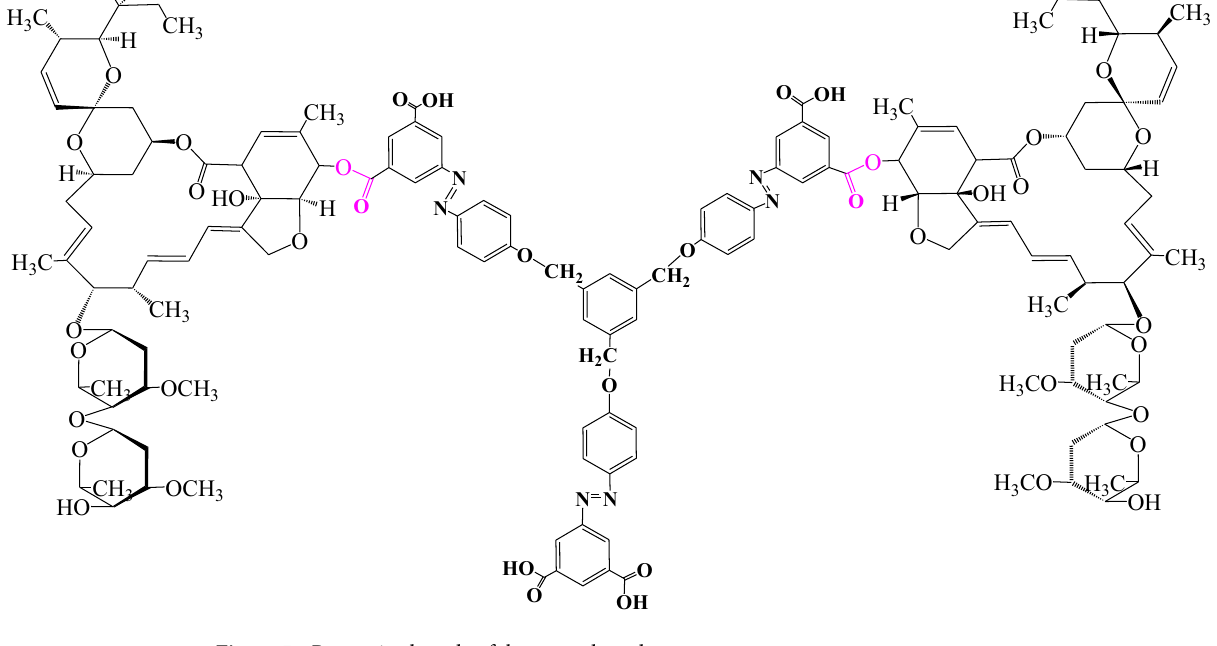
Figure 5. Recognized mode of the reacted